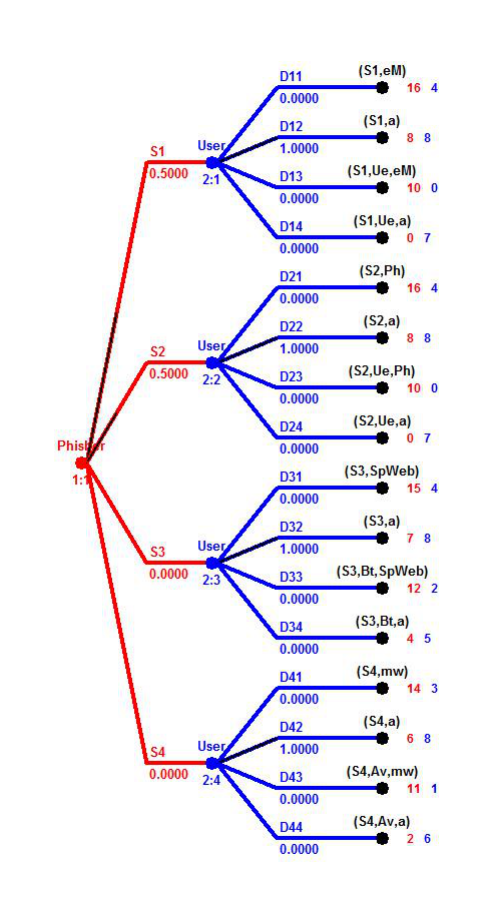
Figure 4. NE of the model